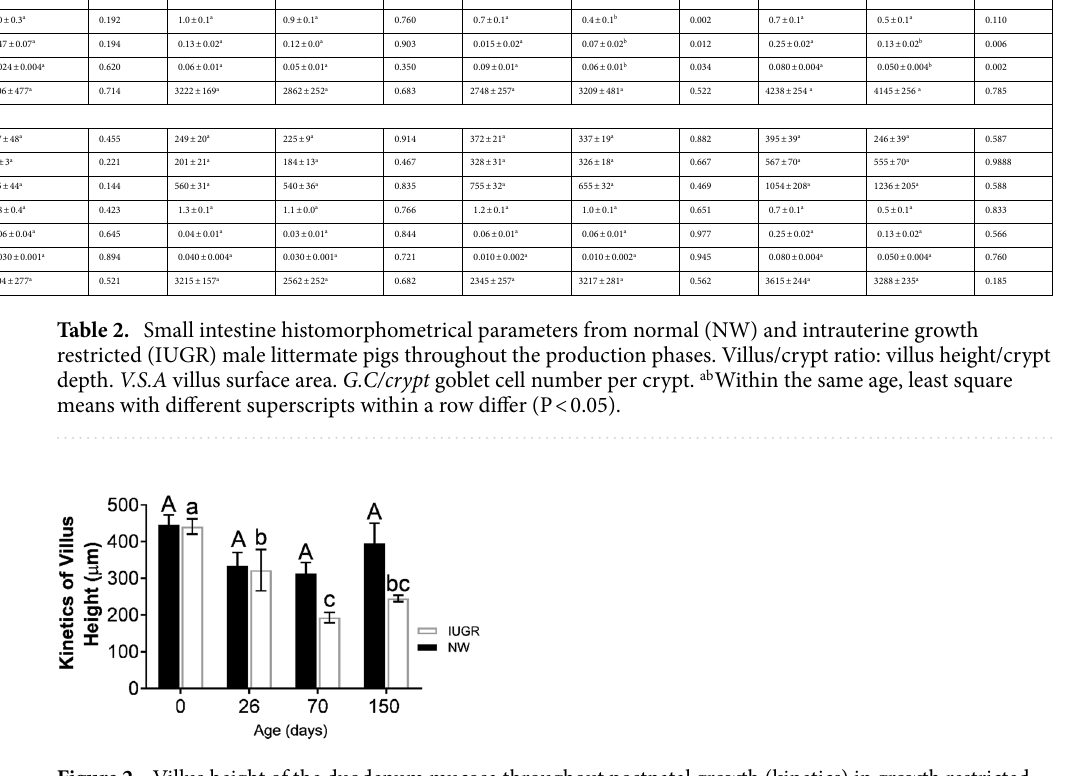
Figure 2. Villus height of the duodenum mucosa throughout postnatal growth (kinetics) in growth restricted (IUGR) and normal (NW) birth weight male littermate pigs. Villus height decreased sharply from birth to 70 days of age in IUGR pigs (black square), reaching its lowest height at this age. On the other hand, villus height remained relatively stable in the NW littermates in the same period. Superscript a, b: means differ statistically between groups (P < 0.05). Error bars represent the standard errors of the